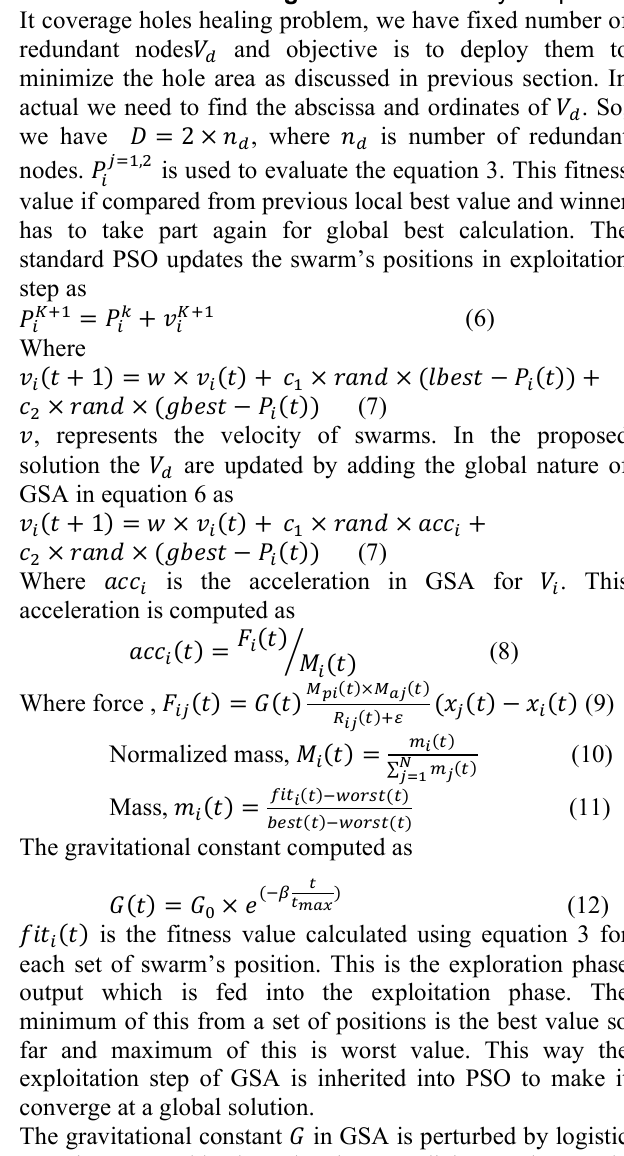
16. End for loop 𝒂𝒂𝒔𝒔𝒔𝒔𝒕𝒕𝒃𝒃𝒉𝒉𝒔𝒔𝒔𝒔𝒕𝒕𝒔𝒔𝒉𝒉𝒏𝒏 = 𝒔𝒔𝒂𝒂𝒔𝒔𝒔𝒔𝒕𝒕 𝒔𝒔 Algorithm 3. Pseudo code for hybrid optimization